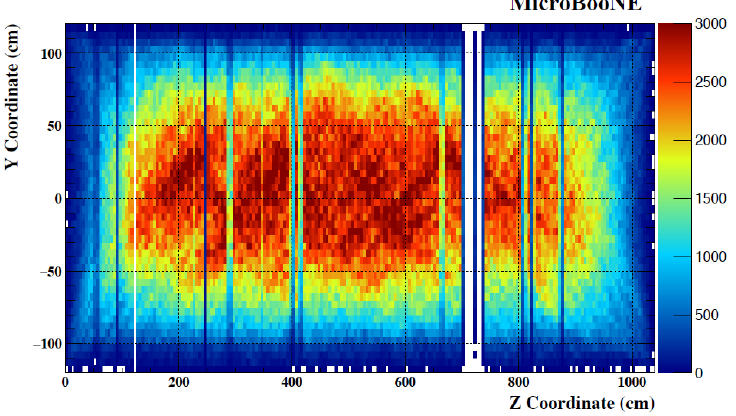
Figure 4. Display from data of number of hits measured as a function of position of the detector height (Y) and length (Z). The image is from